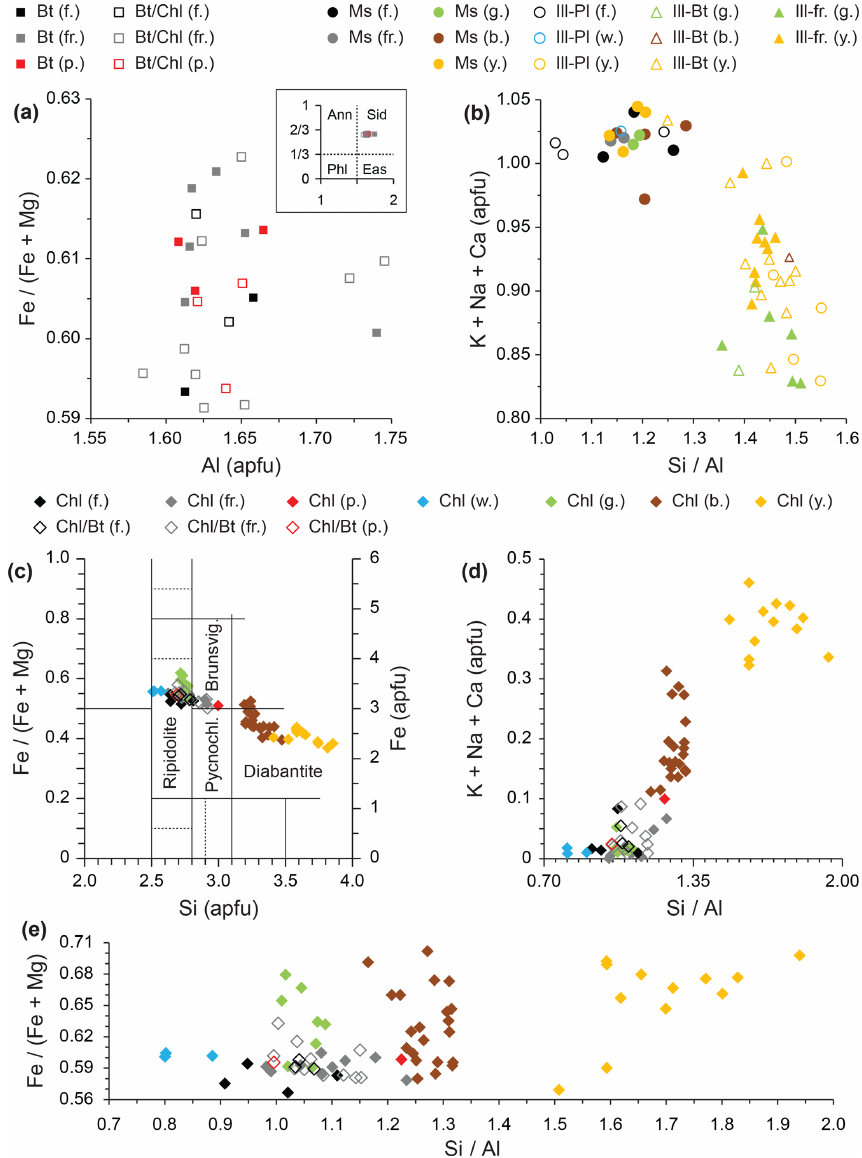
Figure 8. Chemical composition of analyzed minerals. (a) Biotite (Bt) and biotite lamella in chloritized biotite (Bt / Chl); (b) muscovite (Ms), illite in plagioclase (Ill-Pl), in pseudomorph after biotite (Ill-Bt) and in fracture (Ill-fr.); (c, d, e) chlorite (Chl) and chlorite lamellae in chloritized biotite (Chl / Bt), (c) classification diagram after Hey (1954). Atoms per formula unit (apfu) calculated based on 11 oxygens (a, b) and 14 oxygens (c, d, e) . Facies – f.: fresh, fr.: fractured, p.: pink, g.: green, b.: brown, y.: yellow, w.: weakly altered. Ann: annite,